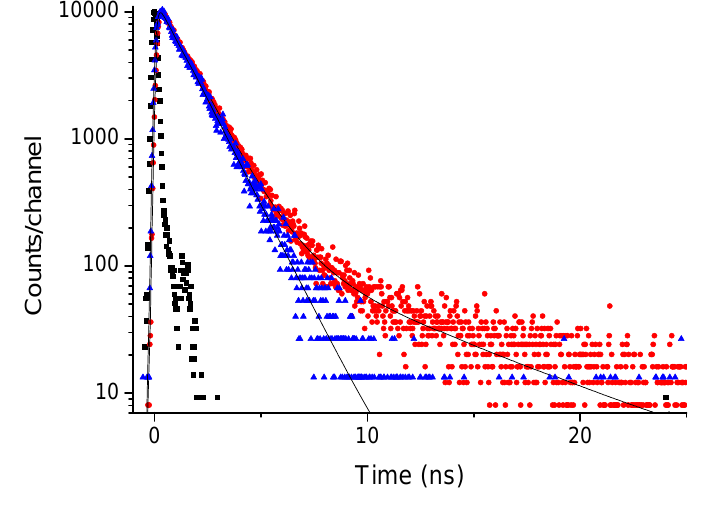
Figure 7. Emission decay of Acetonide-G2-prop-TPPZn (0.050 mM). Red dots: Excited at 403 nm with emission monitored at 650 nm. Blue triangles: Excited at 403 nm with emission monitored at 600 nm. Black squares is system response used for de-convolution fit; slit 32 nm.